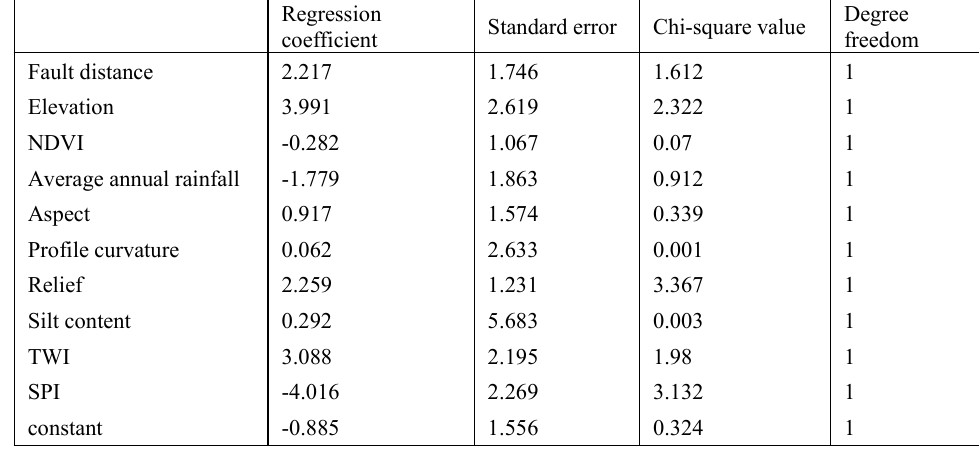
Table 4 . Binary regression analysis table.